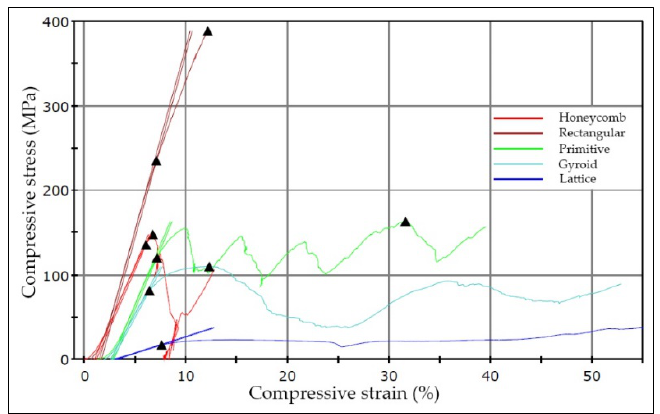
Figure 10. Stress-Strain compression results of scaffolds produced using the selective laser melting.